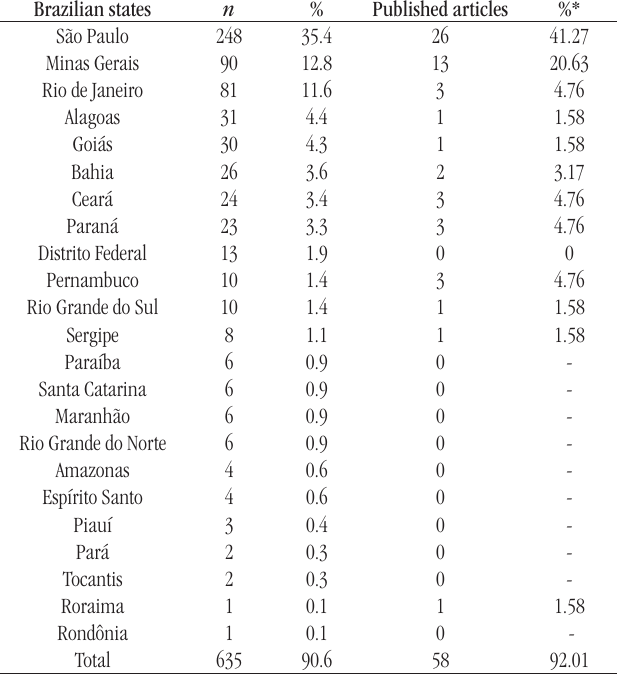
taBLE 1 − Relationship between absolute and relative values of the papers presented as abstracts and articles published, according to nationality Nationality